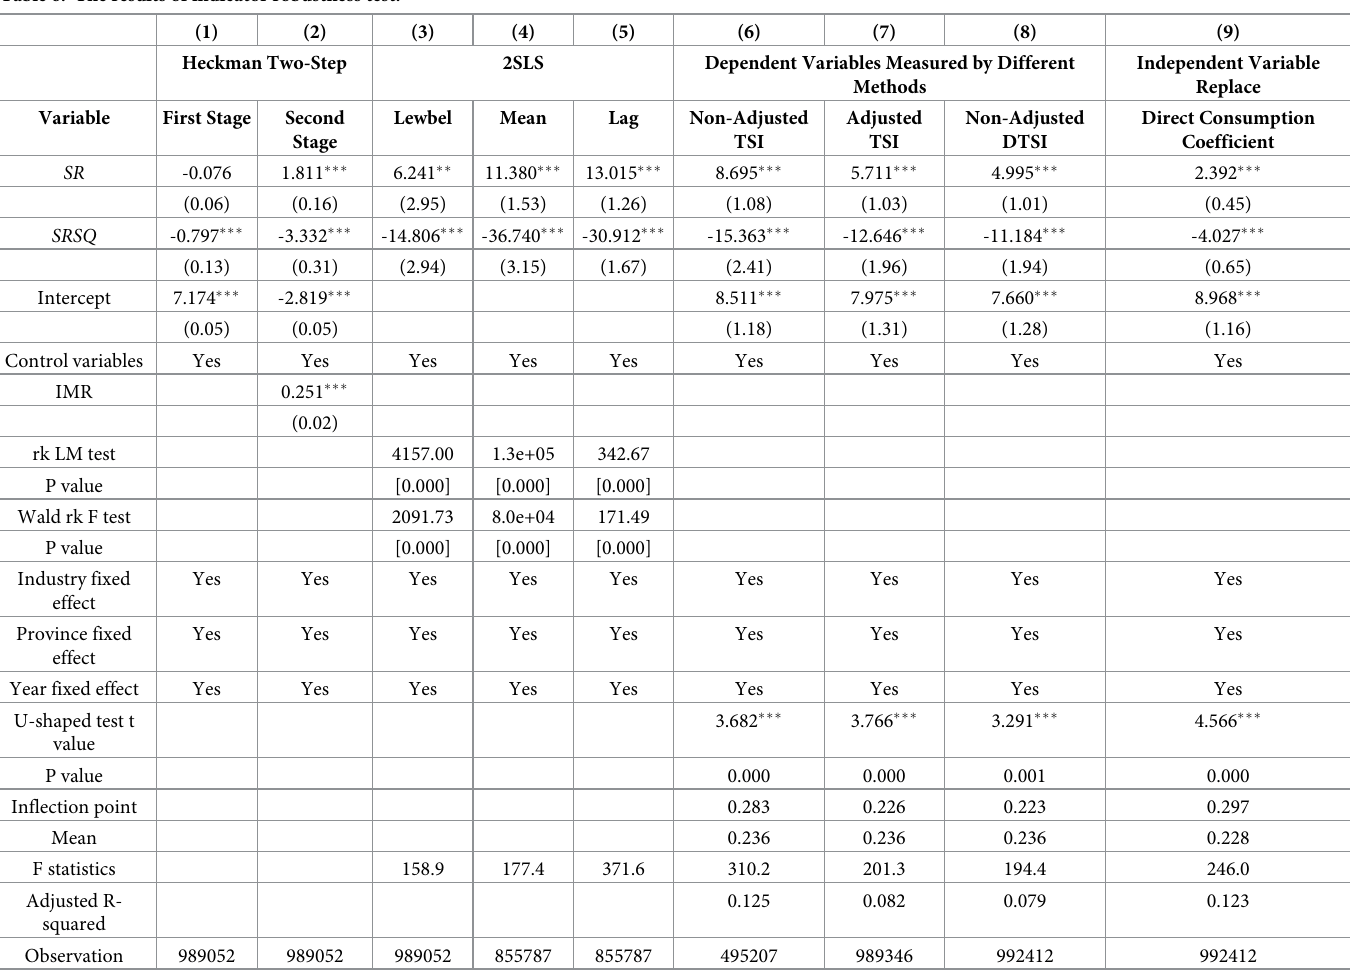
Table 6. The results of indicator robustness